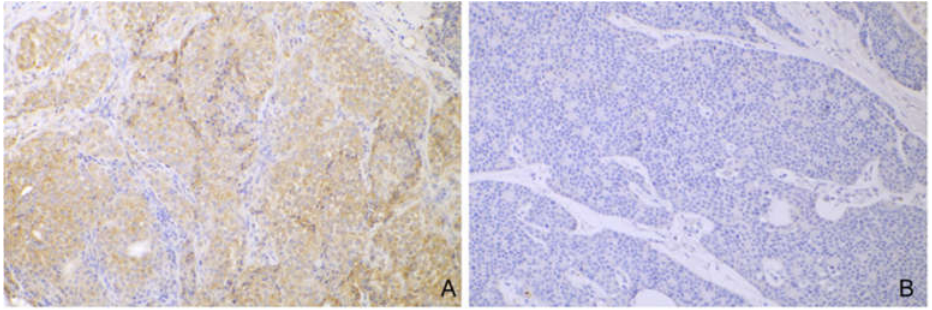
Figure 2. PD-L1 expression in canine AGASACAs (20× magnification). ( A ) Representative case with diffuse and moderate expression of PD-L1 (case #18). ( B ) Negative case (case #20).